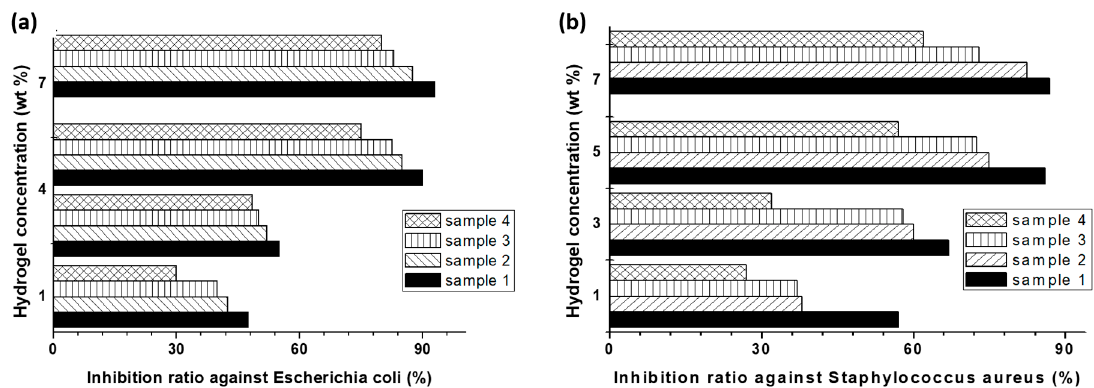
Figure 6. Inhibition ratio against Escherichia coli ( a ) and Staphylococcus aureus ( b ) induced by different concentrations of CS-based hydrogels, after 16 h. Samples: 1 (CS- g -PNIPAAm with 30.6% CS and 69.4% PNIPAAm), 2 (CS- g -PNIPAAm with 25.3% CS and 74.7% PNIPAAm), 3 (CS- g -PAAm, with 22.7% CS), and 4 (CS- g -PNIPAAm-g-PAAm with 12.9% CS) [adapted from 295].